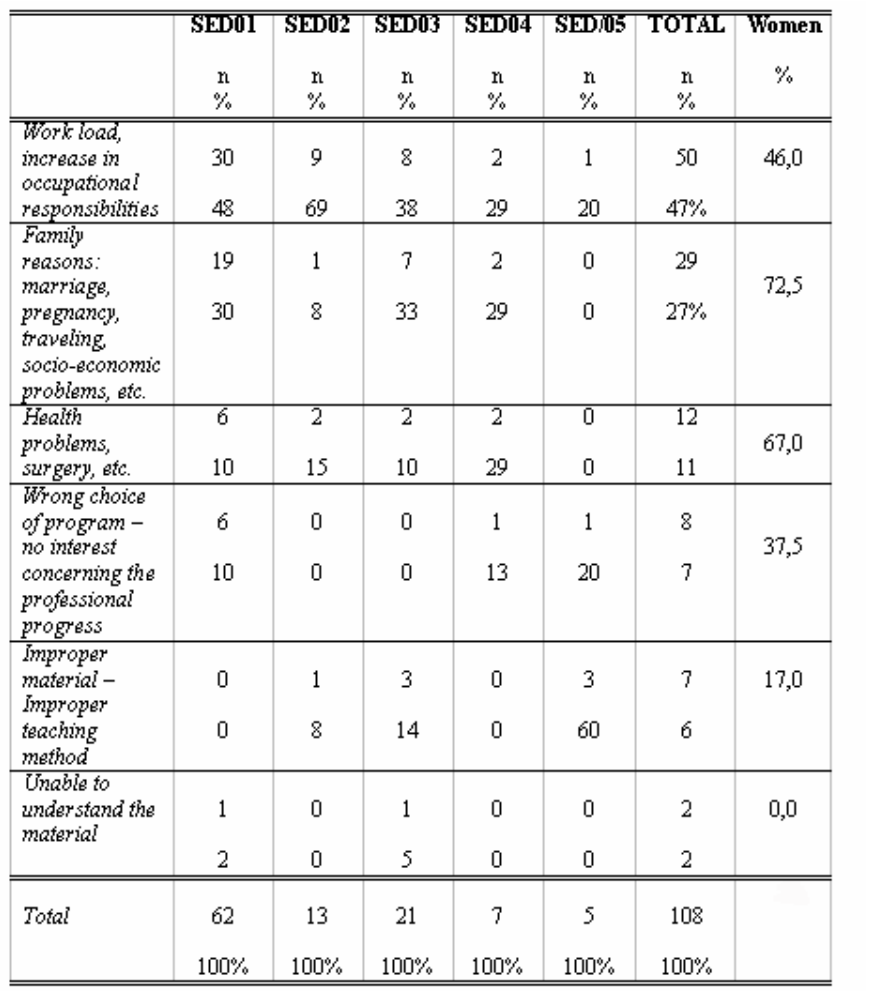
Table 5. Reasons cited by students for dropping